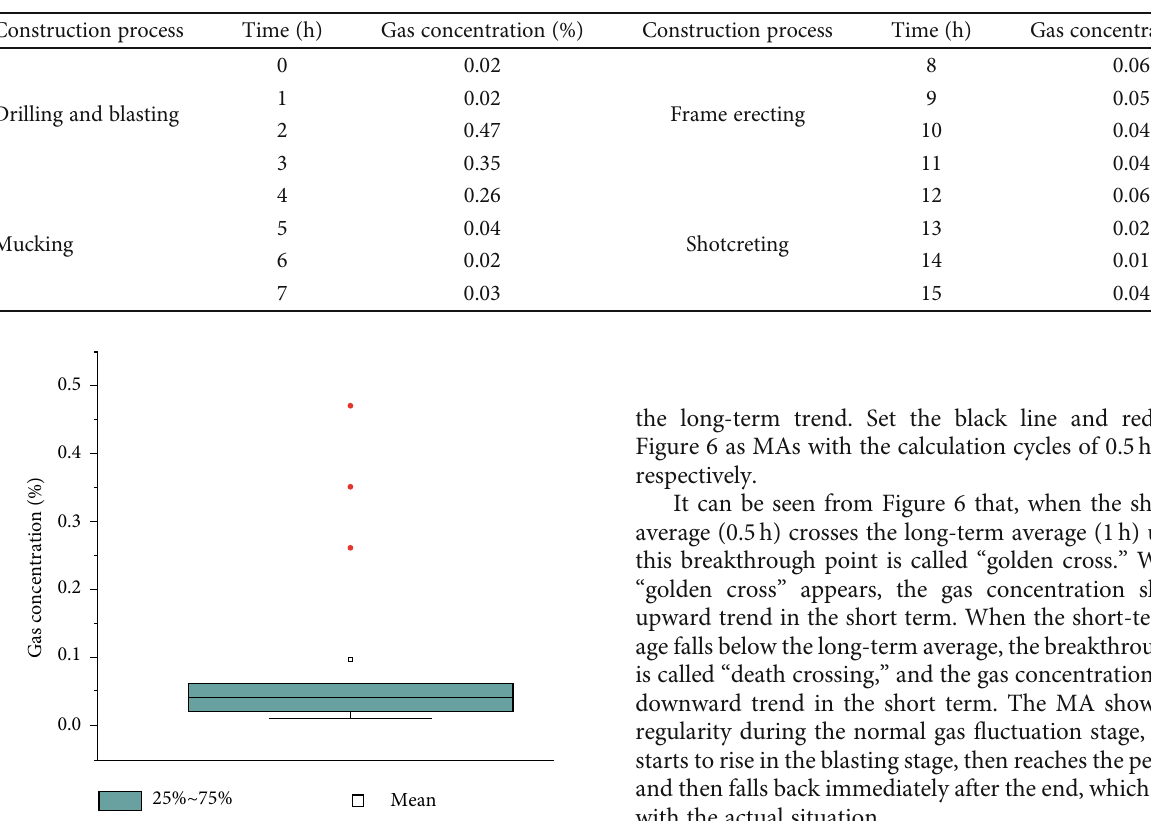
Table 2: Gas concentration in di ff erent construction processes at the tunnel face.